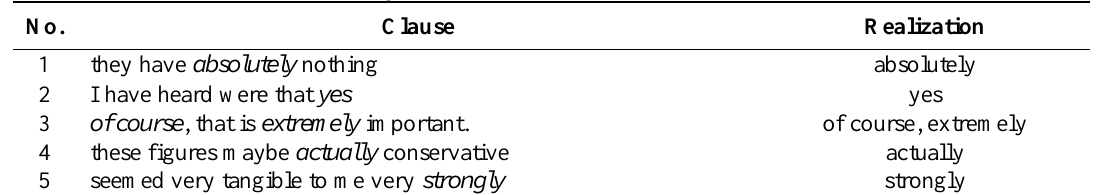
Table 3. Heteroglossic - Contract – Proclaim – Concur